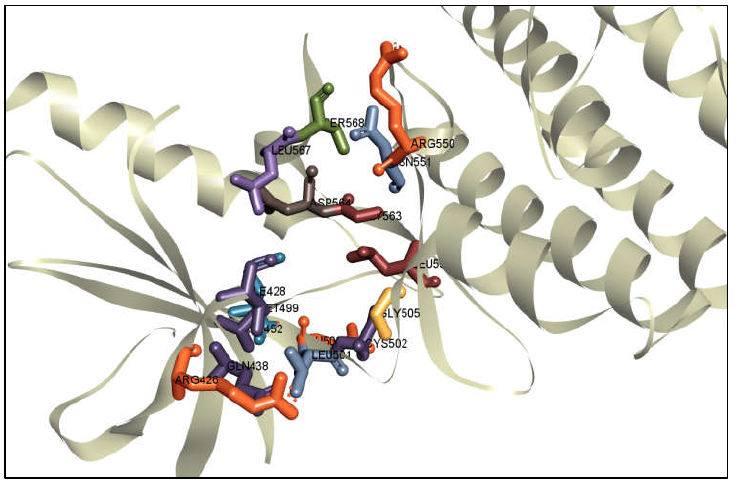
Figure 3. Showing the active site and correspondence binding site of FAK1 protein. Cylinder shapes with red, purple, orange, yellow, blue colors and so on, respectively, with their binding site position of the FAK1 protein.